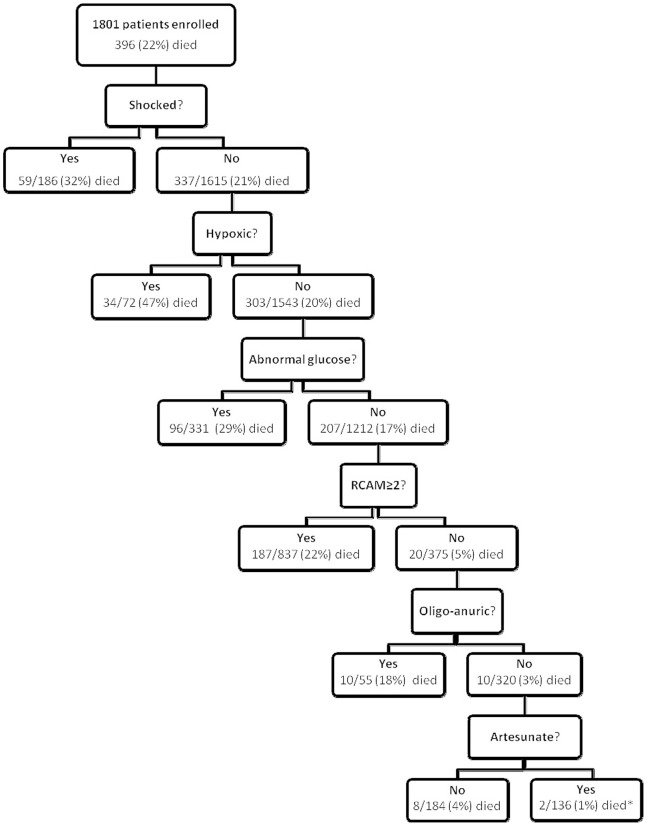
Performance of the clinical algorithm in the four studies.*Both died >48 hours after enrolment.